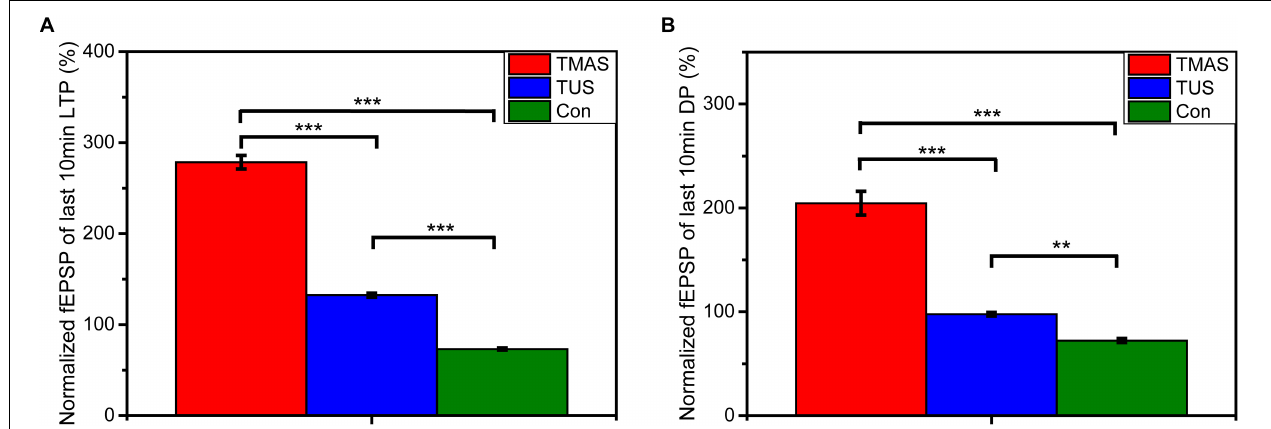
FIGURE 12 | Normalized fEPSPs of (A) the last 10 min of LTP and (B) the last 10 min of DP ( n = 6). Data were plotted as mean ± SEM. Red, blue, and green denote the TMAS group, TUS group, and Con group, respectively. ∗∗ p < 0.01, ∗∗∗ p < 0.001.